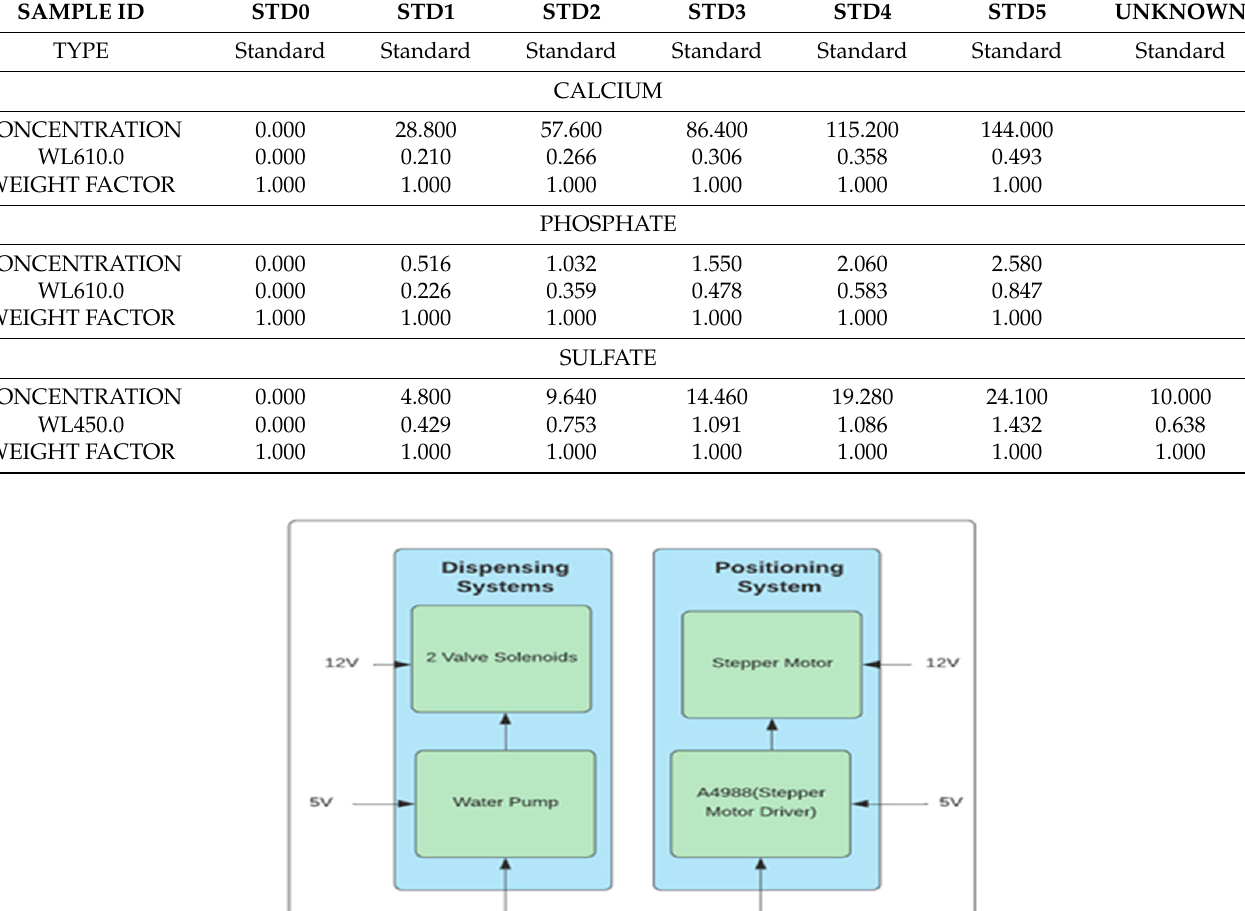
Table 1. Concentration calibration data for Calcium, Phosphate and Sulfate.